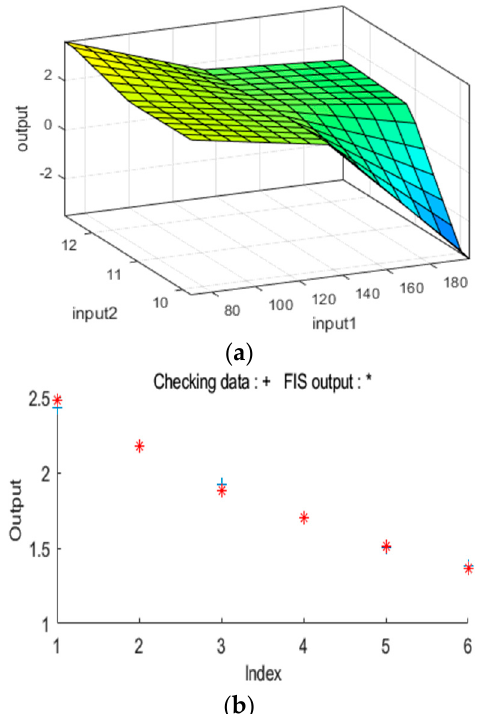
Figure 8. The results of neural network training of swing speed ( a ) output surface after fuzzy neural network training and ( b ) comparison diagram of verification data and network output data.